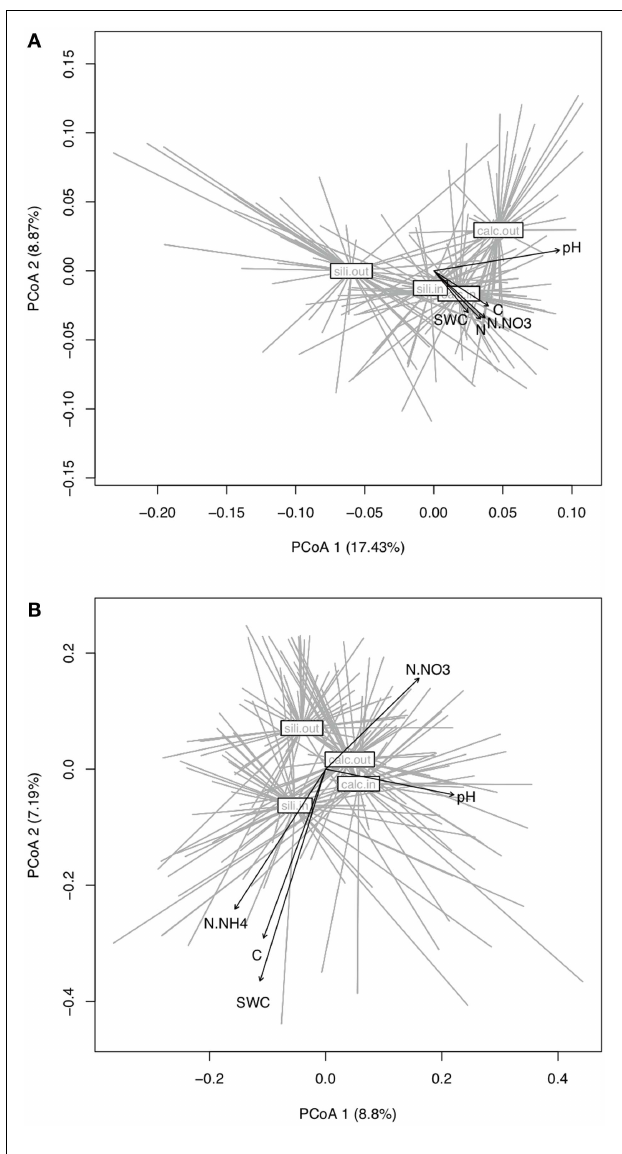
FIGURE 4 | Principal CoordinateAnalysis (PCoA) of the bacterial (A) and fungal (B) dissimilarity matrices (Bray – Curtis) and vector-fitting of the environmental variables. Communities were grouped to the centroid by bedrock and habitat. Arrows represent environmental variables that correlate significantly with the sample coordinates ( P < 0.001, 999 Monte-Carlo